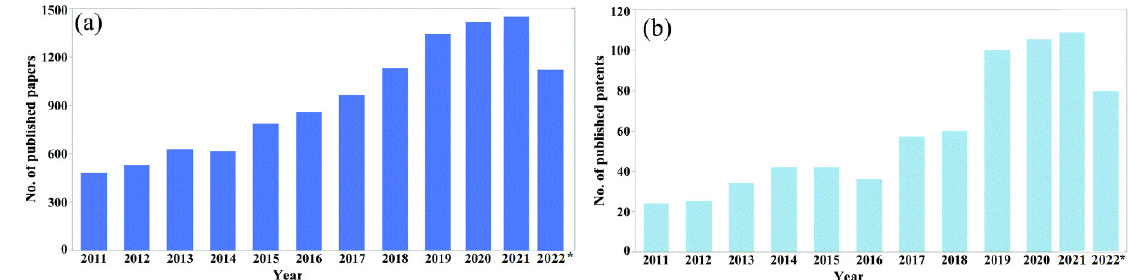
Figure 1. Number of published ( a ) papers and ( b ) patents from 2011 to August 2022 (according to Google Scholar, searched by “self-healing” in the title of the article).